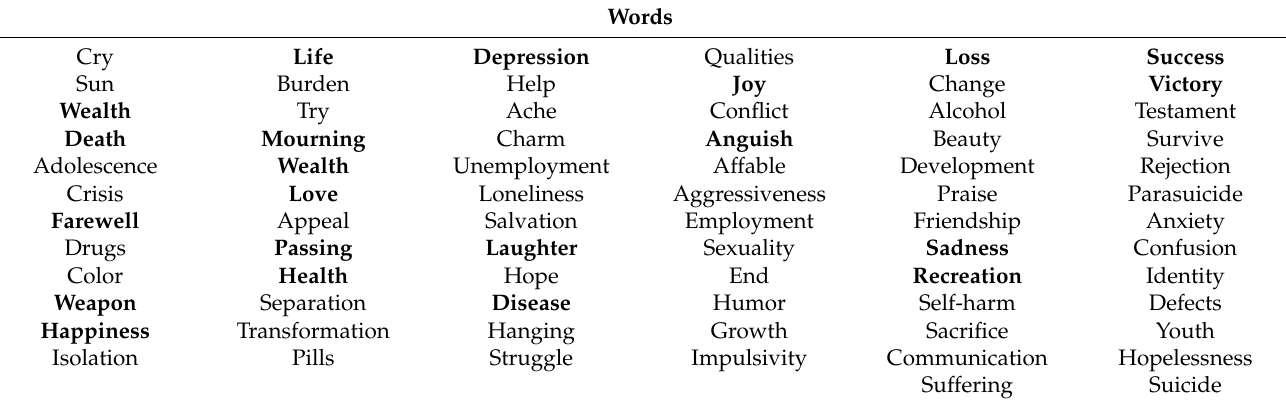
Table 2. Positive and negative words presented to the specialists’ panel. Words